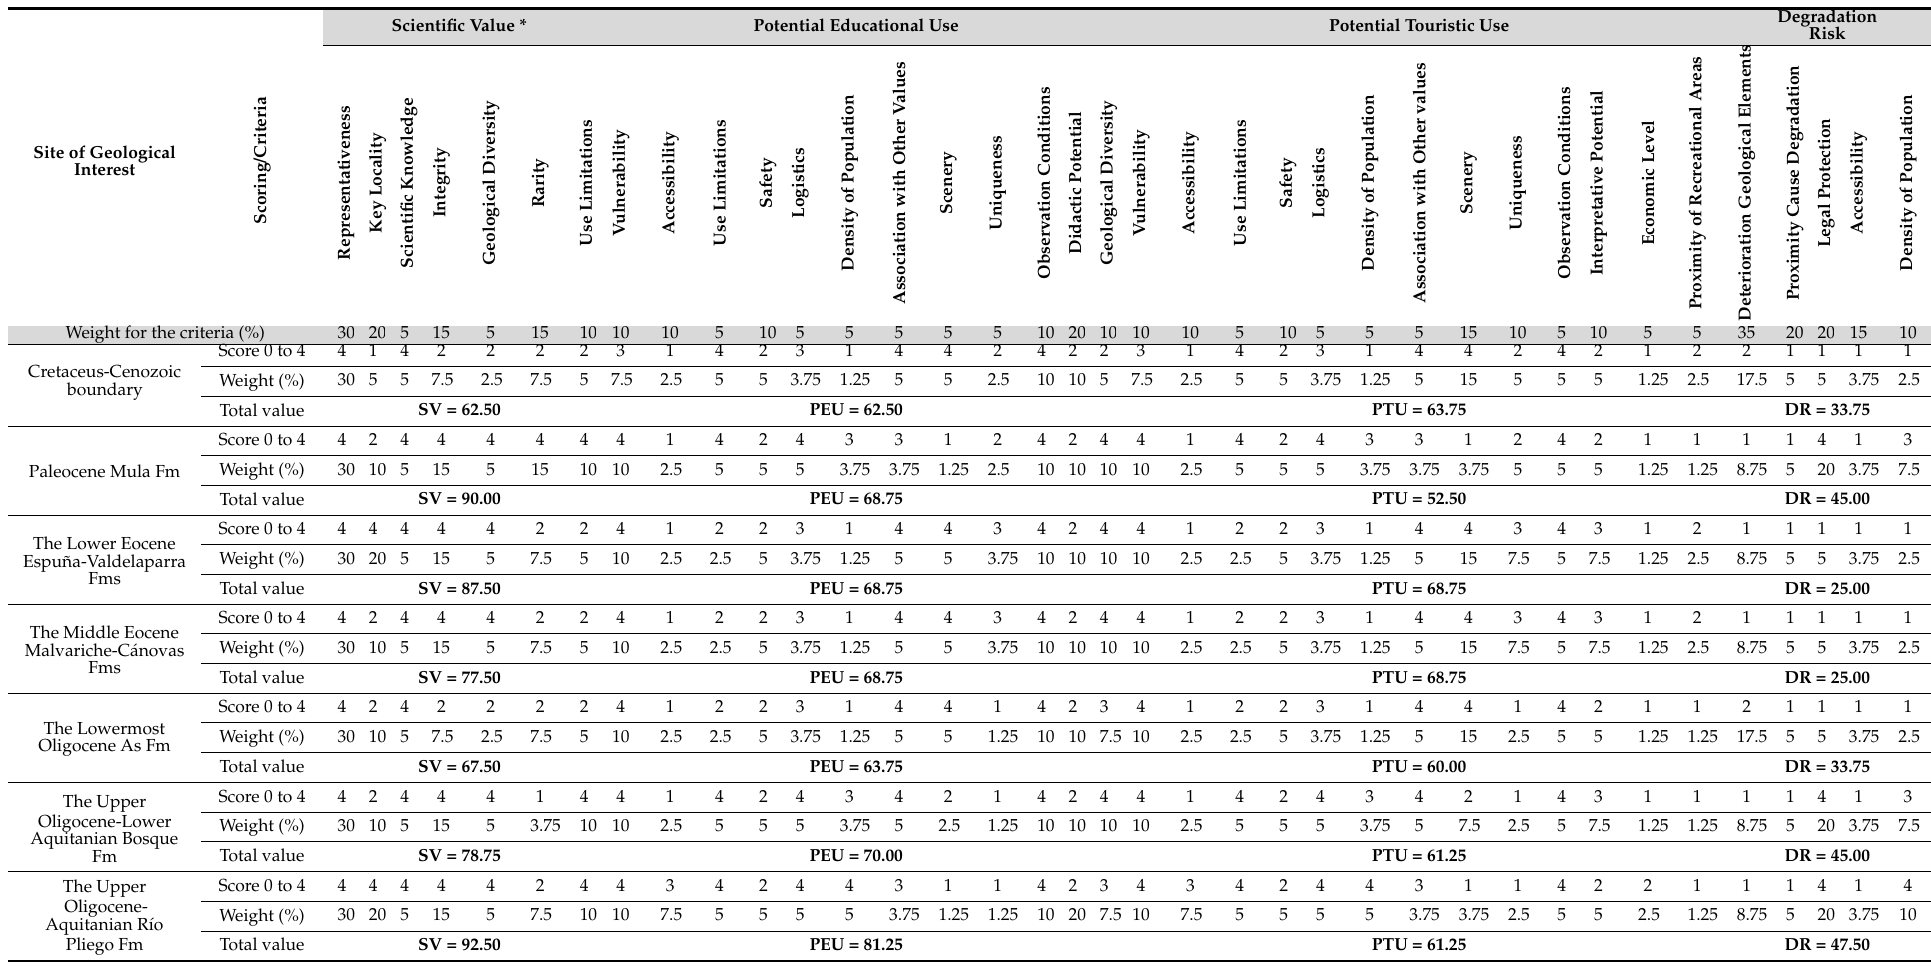
Table 1. Detailed scoring of the eight sites of geological interest selected including scientific value (SV), potential educational use (PEU), potential touristic use (PTU), and degradation risk (DR).